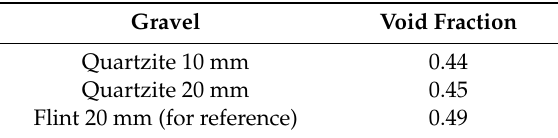
Table 2. Measured void fraction for the gravel samples.